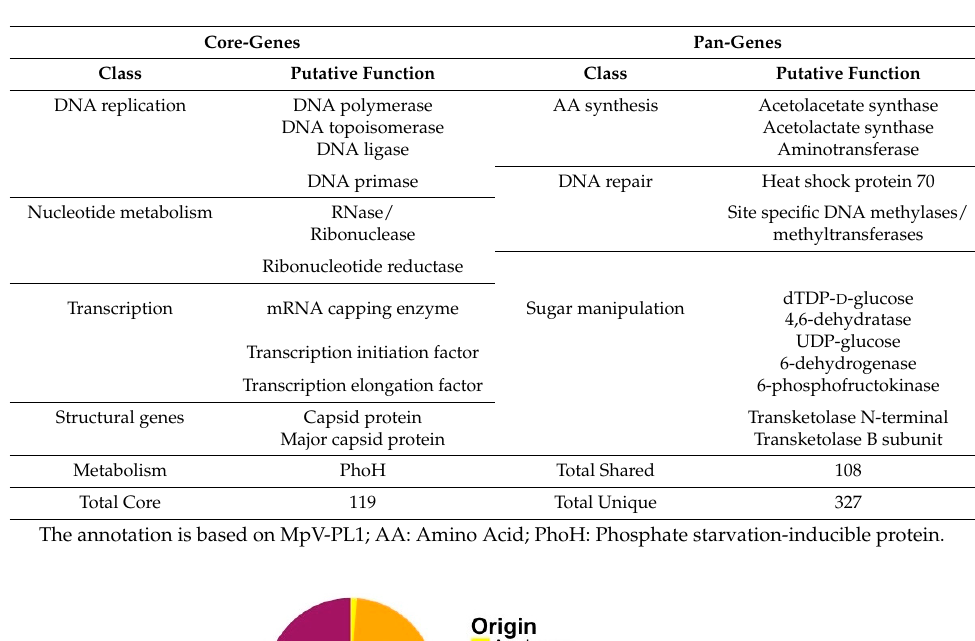
Table 2. Examples of the core and pan-genome of four M. pusilla viruses after a combined cluster and Protein BLAST (BLAST-P) analysis.